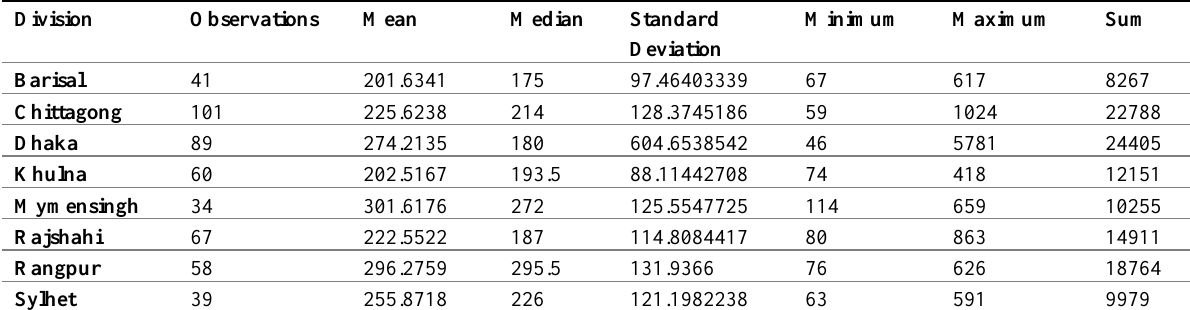
Table 2: Descriptive Statistics (Primary and Equivalent